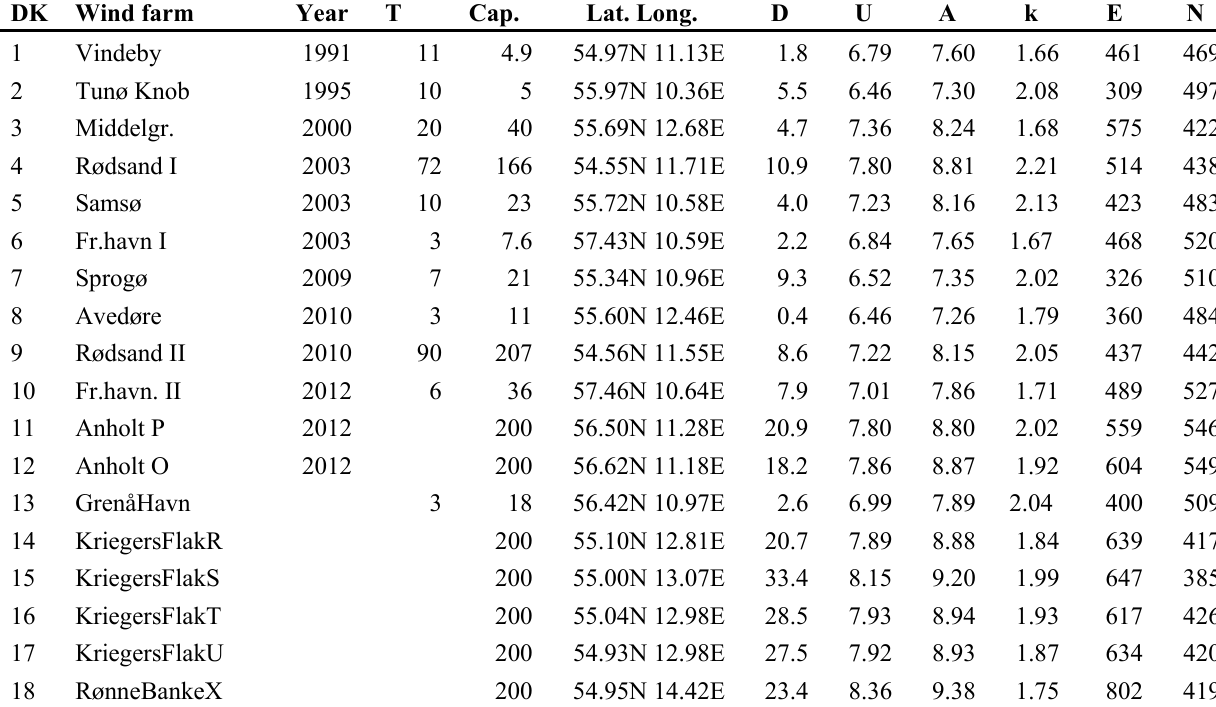
Table A. Offshore wind farms in operation, under construction and in planning: Number of turbines (T), wind farm capacity (Cap. in MW), geographical position (latitude and longitude), distance (D in km) from nearest coastline (from http://www.4coffshore.com/ windfarms) and calculated wind statistics from satellite Envisat ASAR mean wind speed (U in m s − 1 ), Weibull A (m s − 1 ) and k ( − ), wind power density (E in W m − 2 )) and the number (N) of wind samples. Tables are given for Denmark (DK), Sweden (SE), Germany (DE) and Poland (PL).